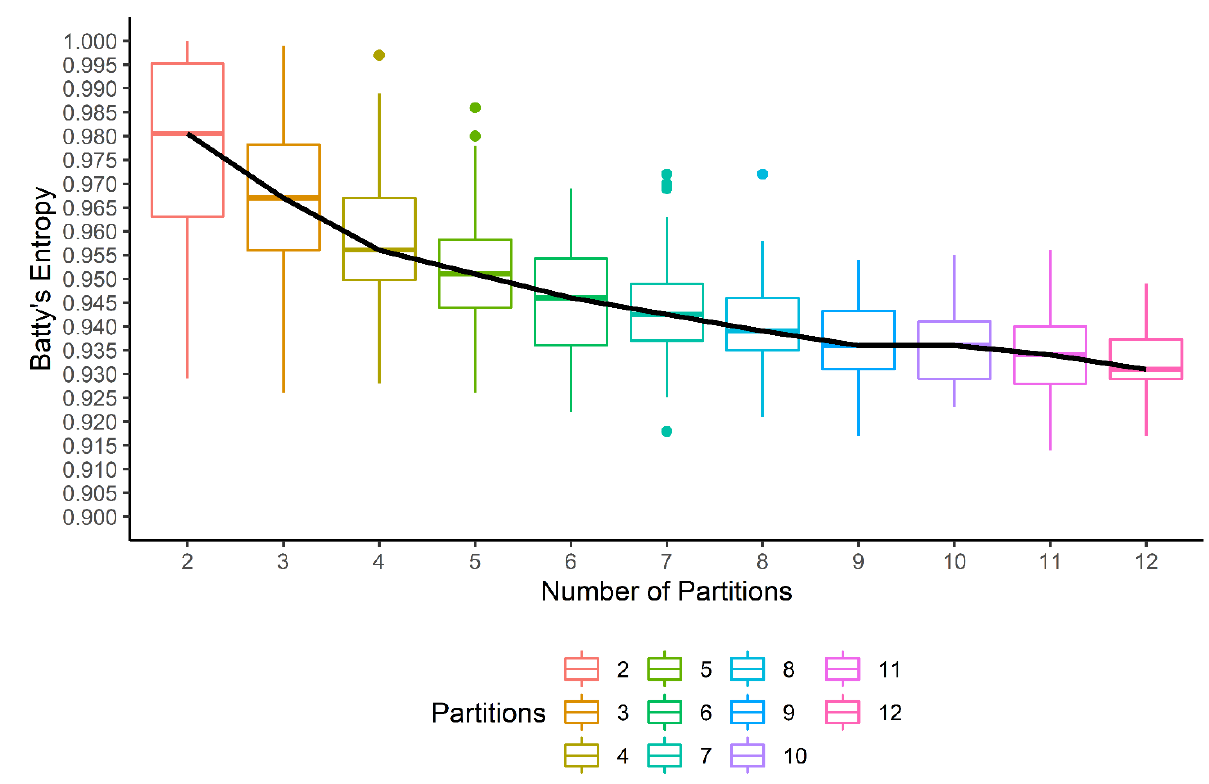
Figure 6. Batty’s spatial entropy as a measure of intratumor heterogeneity of gene ( TBX3 ) expression. For different number of partitions ( x axis) of the tissue space, N = 100 spatial entropy values are calculated ( y axis) and shown with a boxplot. The trend of the median entropy values is shown with a black line.